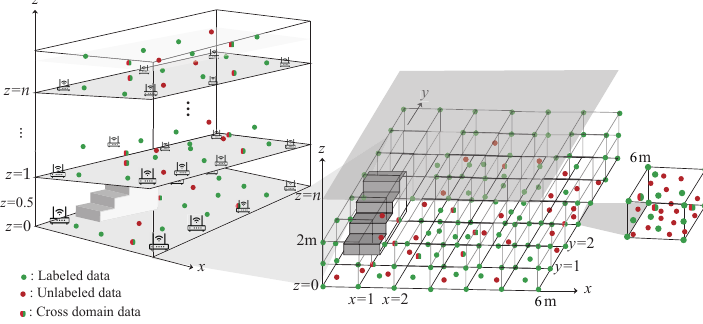
Figure 6. The 3D Data collection